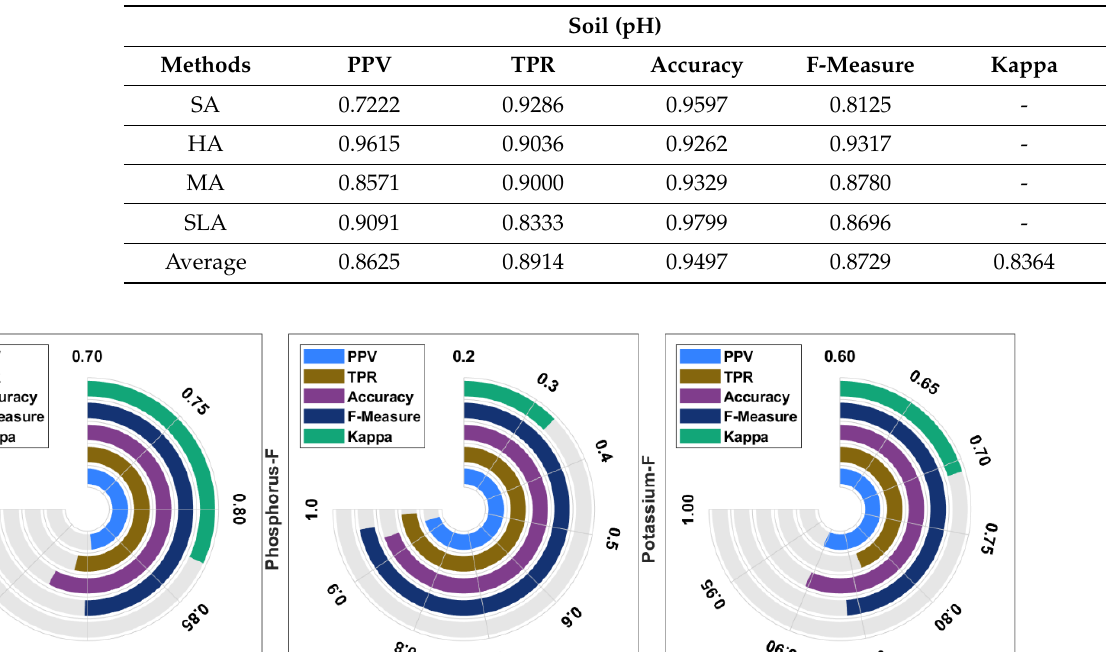
Table 2. Result analysis of ISNpHC-WVE technique on soil pH classification.